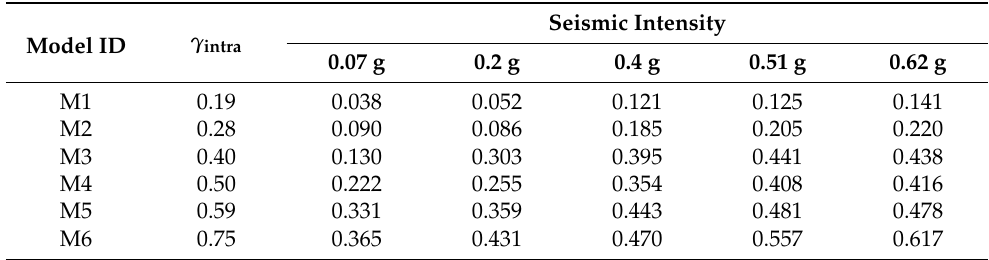
Table 5. The average proportion of base shear along the slope direction is borne by lower- embedding columns.